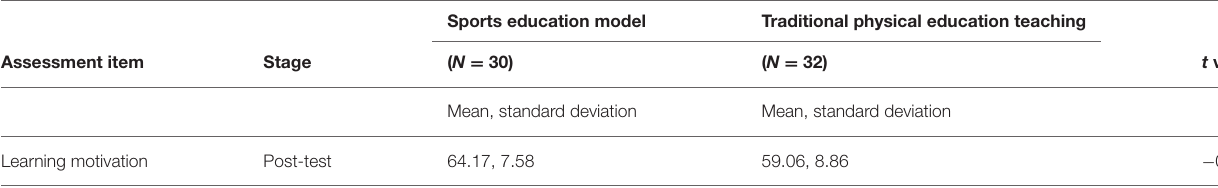
TABLE 4 | Comparison of the two groups: post-test learning motivation effect t